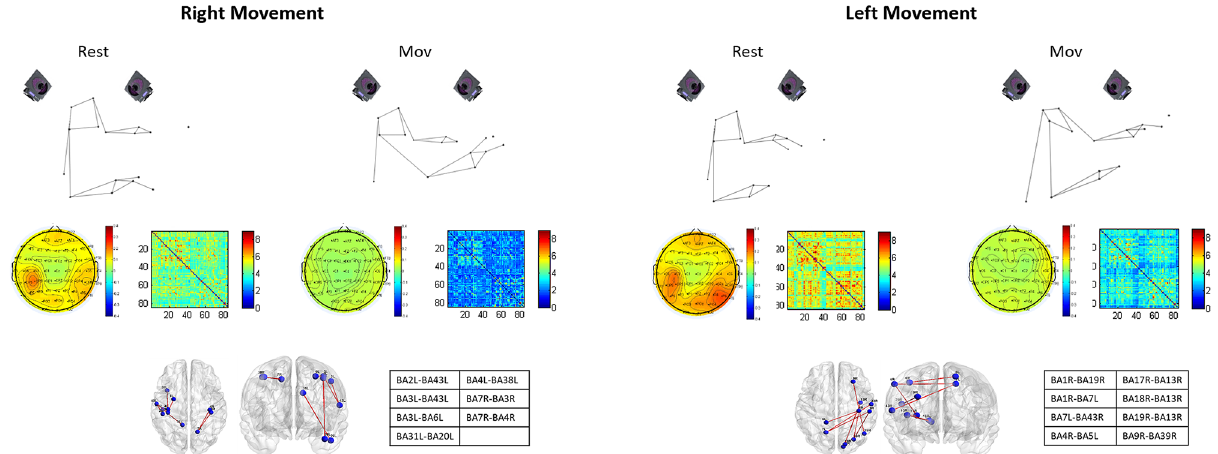
Figure 4. The figure sums up the main changes of cortical activity in α band induced by reach&grasp movement. In the sections A and B of the figure we show, both in Rest and Mov conditions, respectively for the right and left reach&grasp movement: (1) ERD/ERS averaged maps, (2) functional connectivity averaged matrices, (3) Brodmann areas with decreased lagged linear coherence during the reach&grasp